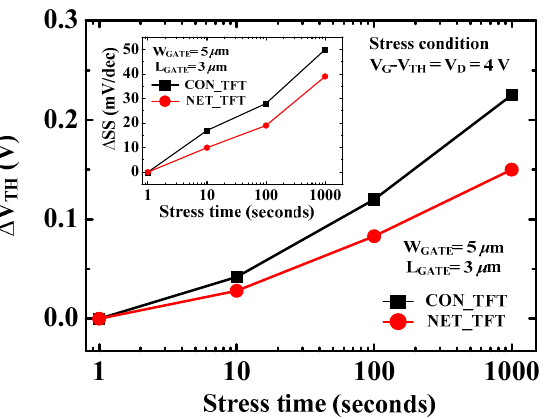
Figure 6. Measured ∆ V TH and ∆ SS (inset) for NET_TFT and CON_TFT with L GATE = 3 µ m under an Figure 6. Measured Δ V TH and Δ SS (inset) for NET_TFT and CON_TFT with L GATE = 3 μ m under an HCI stress condition at V G − V TH = V D = 4 V during 0–1000 s. HCI stress condition at V G – V TH = V D = 4 V during 0–1000 s.